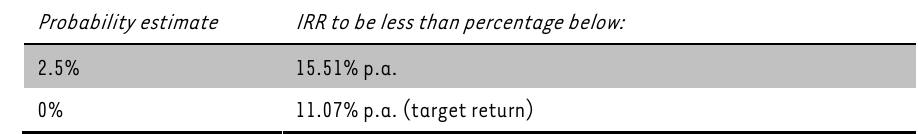
Probabilities of downside IRR of the investments in Set A Probability estimate IRR to be less than percentage